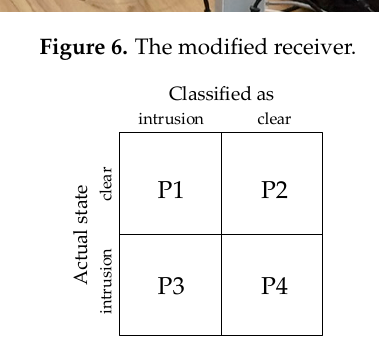
Figure 7. Confusion matrix of intrusion detection. Table 1. Basic information of volunteers.